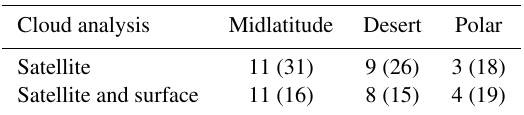
Table 5. Bias (RMS) of the clear-sky surface shortwave calculation compared with observation ∗ (in Wm − 2